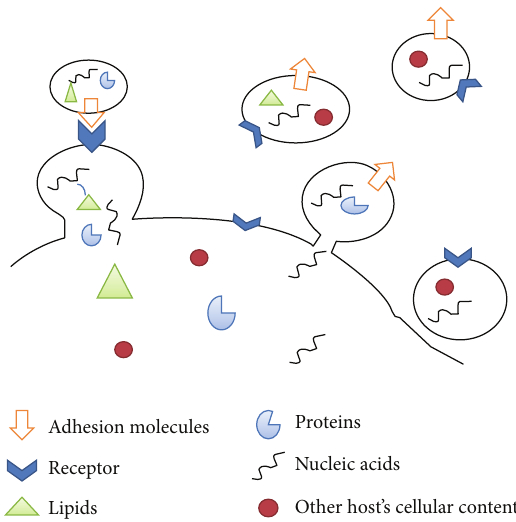
Figure 1: Exosomes properties and function exosomes are secreted membrane vesicles released into the extracellular space and transfer proteins, lipids, nucleic acids, and other hosts’ cellular content. The fusion of the exosome membrane with the target cell plasma membrane results in the release of exosome content into the target cell